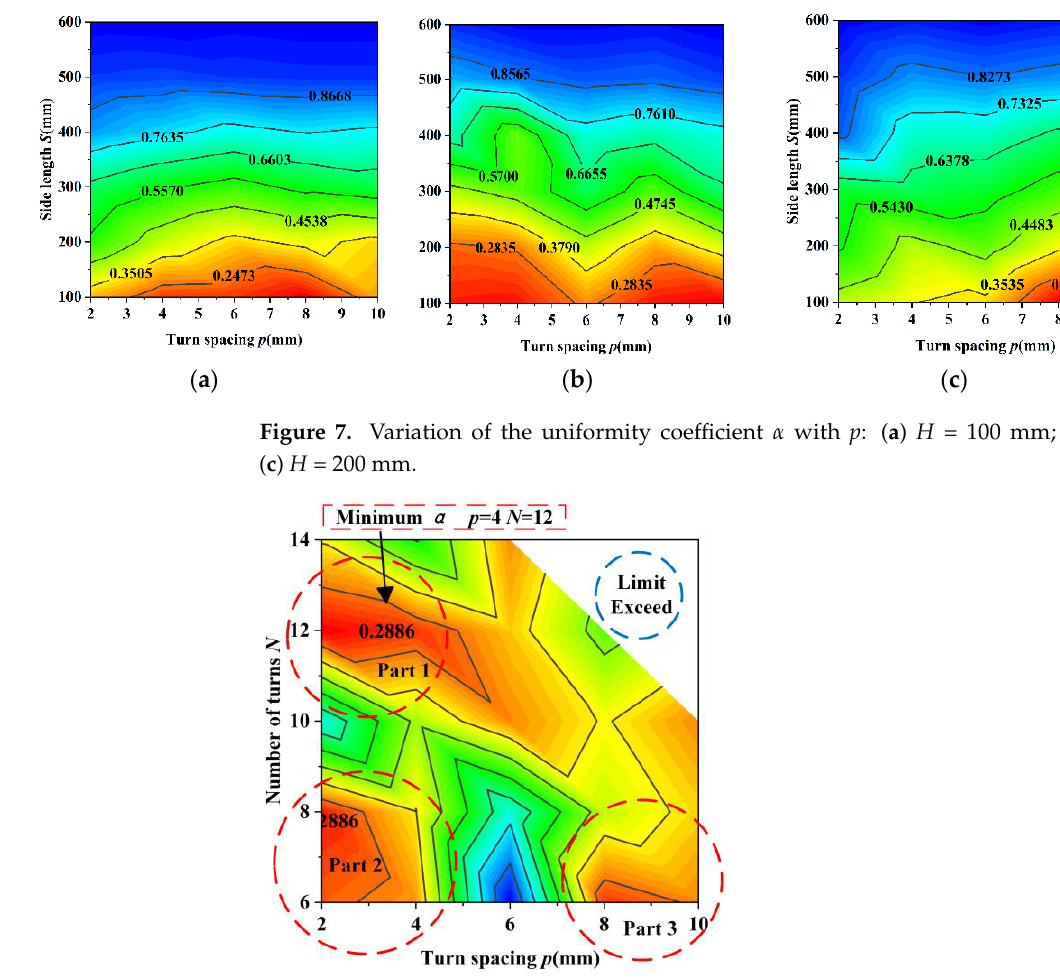
Figure 8. Variation of the uniformity coefficient α with p and N.